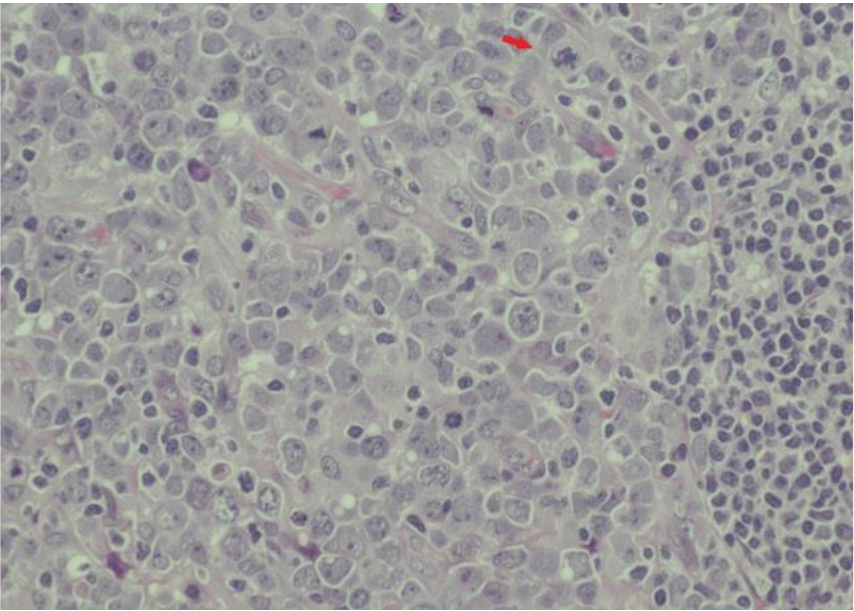
Figure 2. CT scan revealed two lymphadenopathies: right axillary 6.99 cm ( A ) and supraclavicular 2.36 cm ( B ), and multiple adenopathies in the coronal section ( C ). A US-guided, fine-needle aspiration biopsy of the axillary lymphadenopathy was carried out, and suspicion of NHL was suggested. A surgical biopsy of the right axillary adenopathy revealed anaplastic large-cell lymphoma that was ALK negative and CD30 positive, with the presence of elevated Ki-67 proliferation antigen (90%) (Figures 3 and 4).